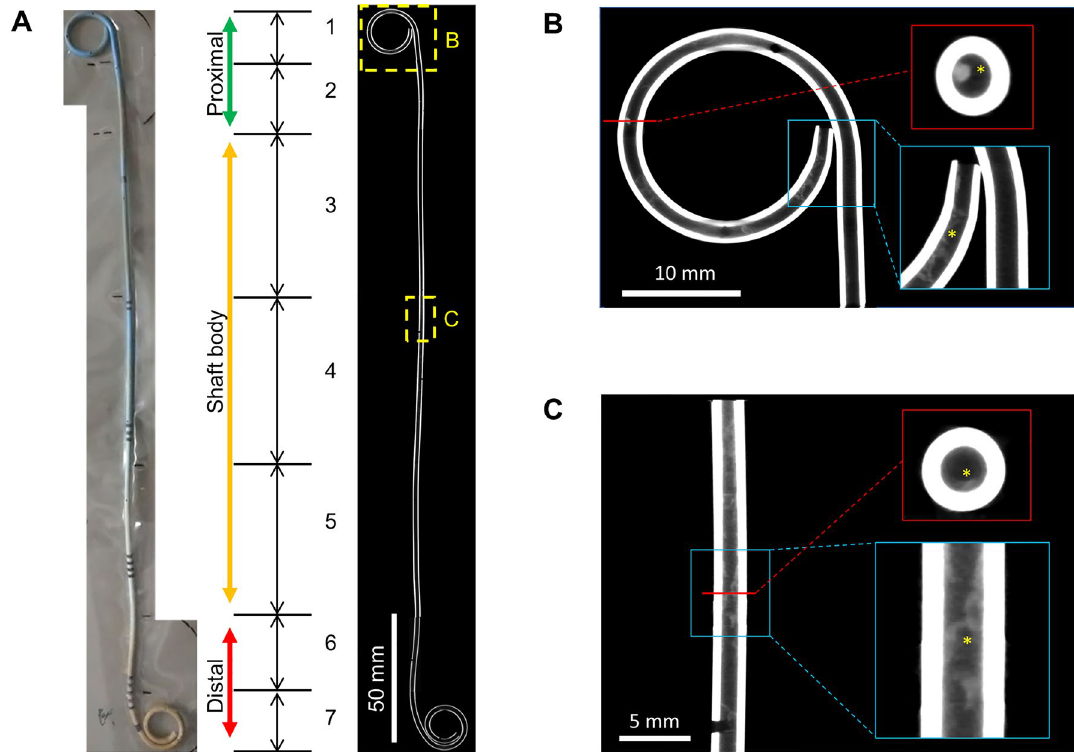
Figure 3. ( A ) Representative micro-computed tomography (micro-CT) imaging of the ureteral stent, combining the divided seven parts. The part surrounded by the dotted line shows a low power field in Fig. 2B and C. ( B ) High power view of the proximal loop. ( C ) High power view of the shaft body. The red line and blue-bordered box indicate axial and coronal (micro-CT) images, respectively. Asterisks indicate inner luminal